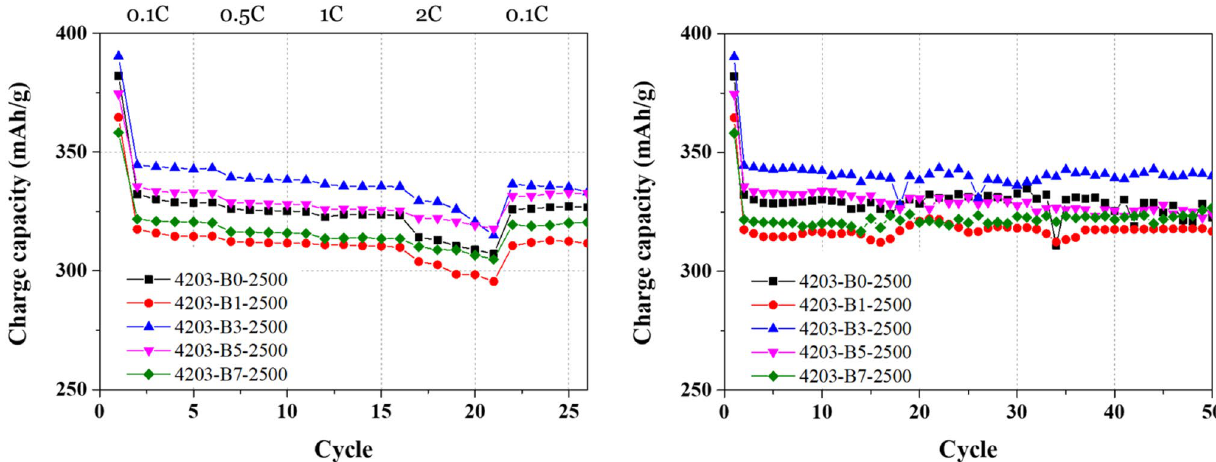
Fig. 10 C-rate performance and cycle retention performance of 4203-BX-2500